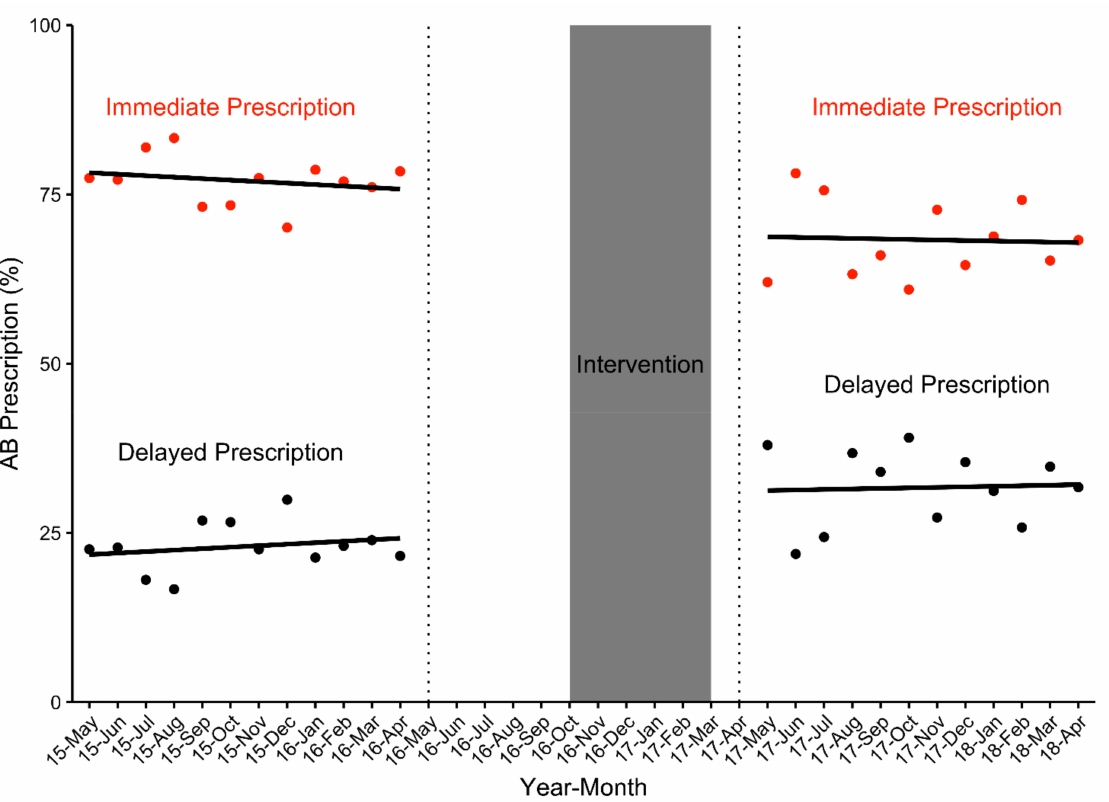
Figure 3. Change in the proportion of antibiotics (% AB prescription) issued to patients with acute respiratory tract complaints for delayed and immediate use pre- and post-intervention ( n = 2150 eligible aRTC